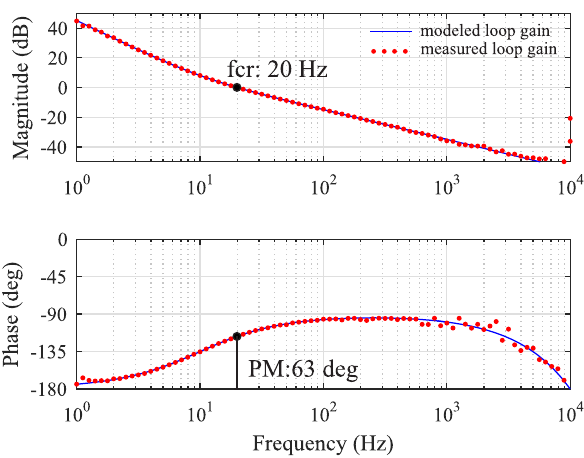
Figure 8. Modeled (solid) and measured (dotted) loop gain of the phase-locked-loop.